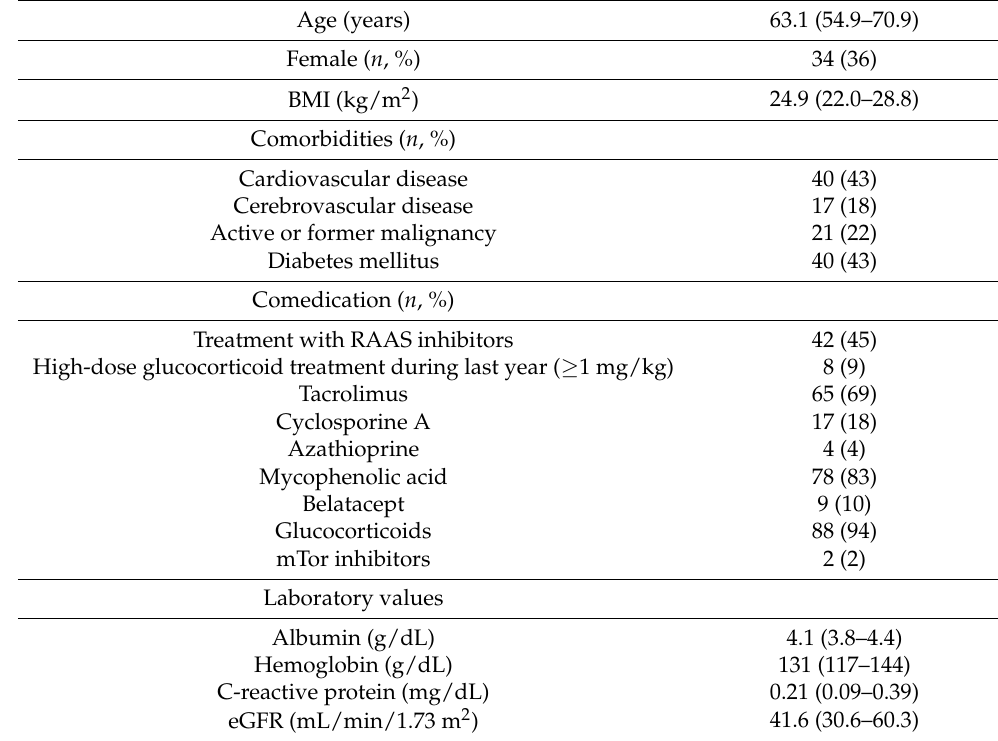
Table 1. Baseline characteristics of 94 kidney transplant recipients. Continuous data are displayed as median and 25% and 75% percentiles. Numerical data are displayed as number of participants ( n ) and percentage (%) where appropriate (sums do not add up to 100% due to